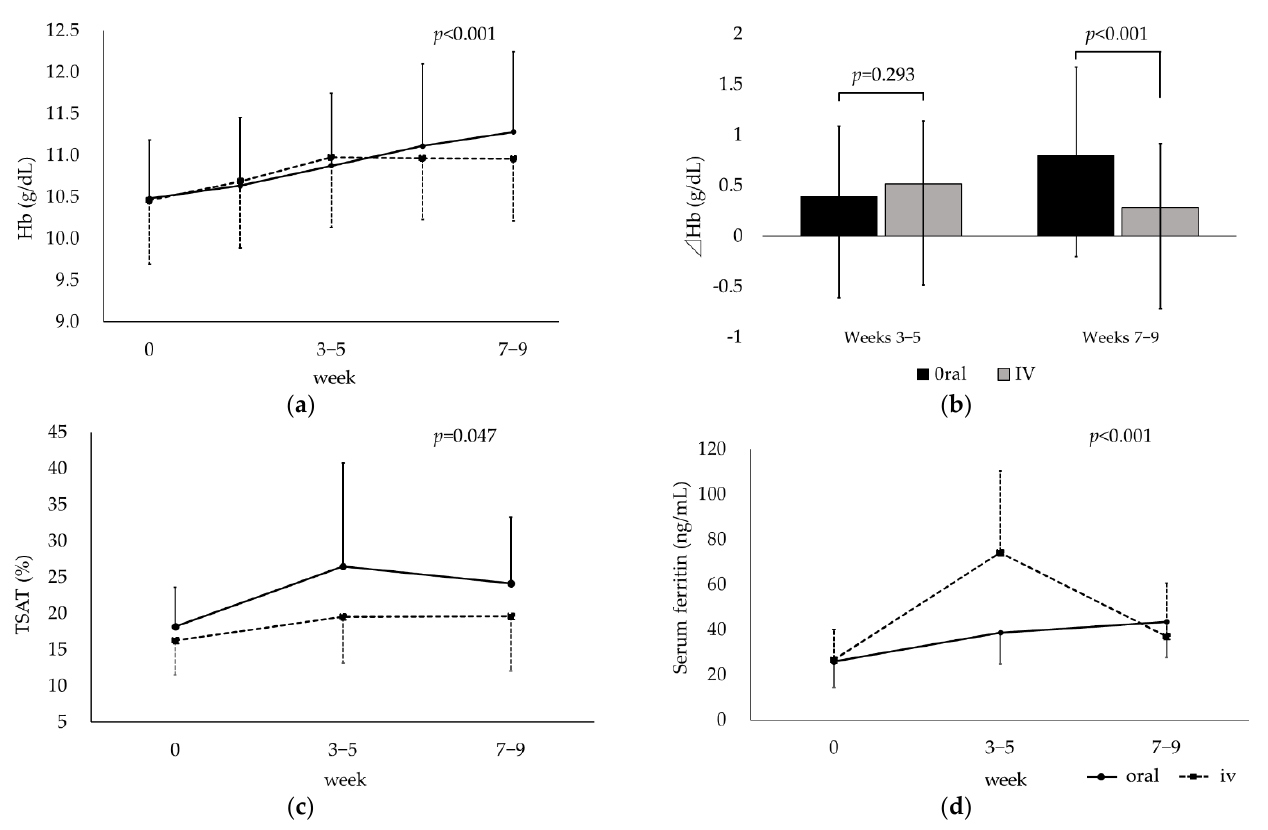
Figure 1. Comparison between oral and intravenous iron replacement therapy: ( a ) hemoglobin (Hb), ( b ) change in Hb from baseline, ( c ) transferrin saturation (TSAT), and ( d ) serum ferritin.